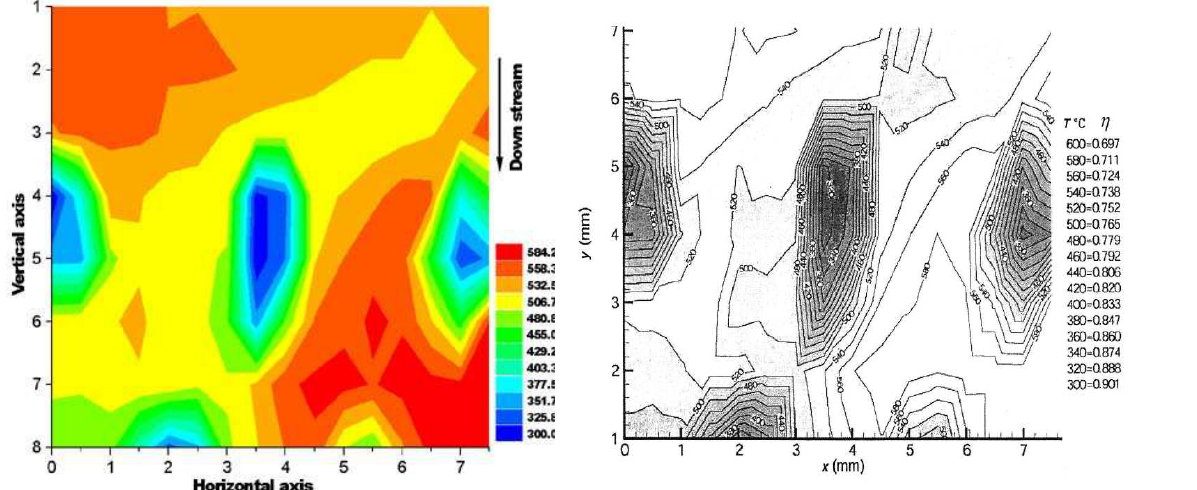
Figure 47. Results showing the temperature distribution/cooling effectiveness inside the combustor: (left)Contour map [22]; (Right)Colour thermal map [84].